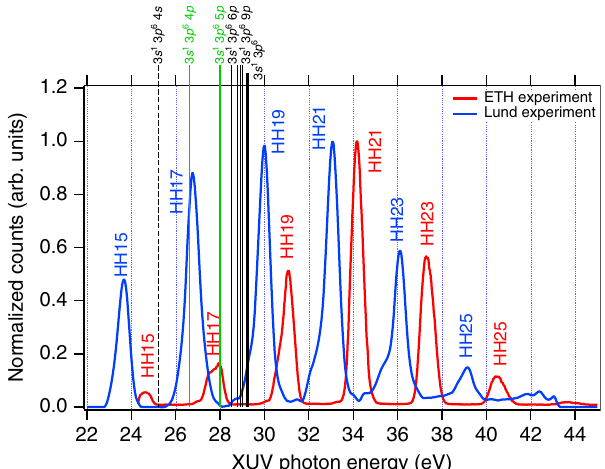
Fig. 1 Extreme ultraviolet spectra of the attosecond pulse trains used in the experiment. The XUV radiation is generated by focusing the IR beam into an argon target. The vertical lines show the energy position of the 3 s − 1 np series of autoionizing states converging to the 3 s threshold. In the ETH experiment (red line), the 5 p state (at 27.99 eV, highlighted in green) is resonant with harmonic 17 (HH17), while in the Lund experiment (blue line) it is the 4 p (26.6 eV, also highlighted in green). The black dashed line indicates the position of the 3 s − 1 4 s autoionizing